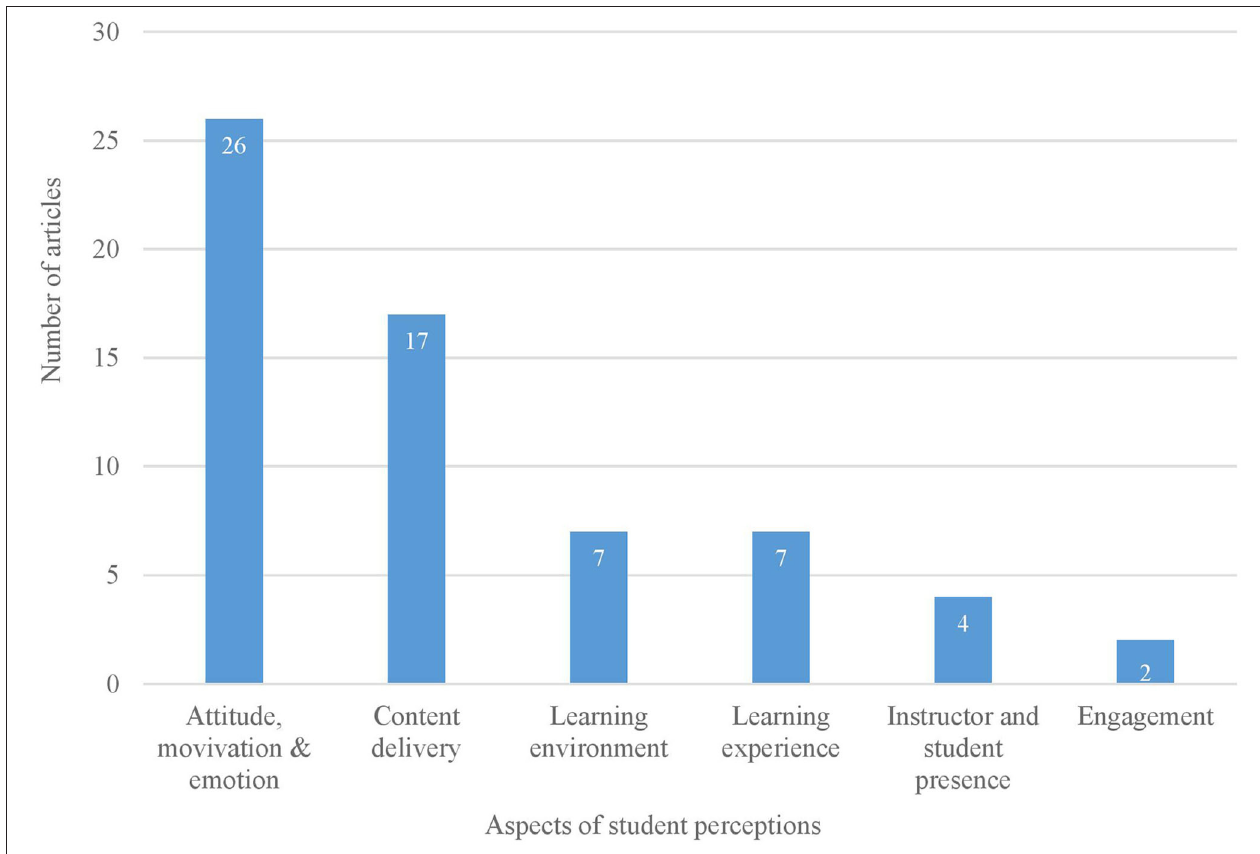
FIGURE 8 | Aspects of student perceptions of FC.